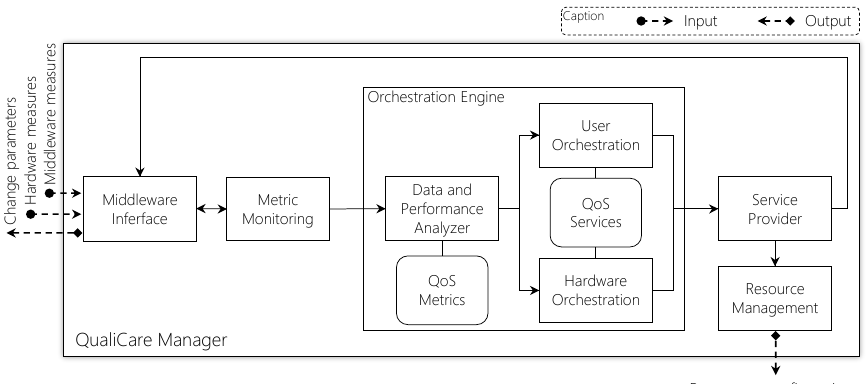
Figure 7. QualiCare Manager components, inputs, and outputs. The module receives measurements collected from the middleware and evaluates them based on metrics and services. The output are resource and parameters reconfigurations, if necessary, to guarantee QoS.